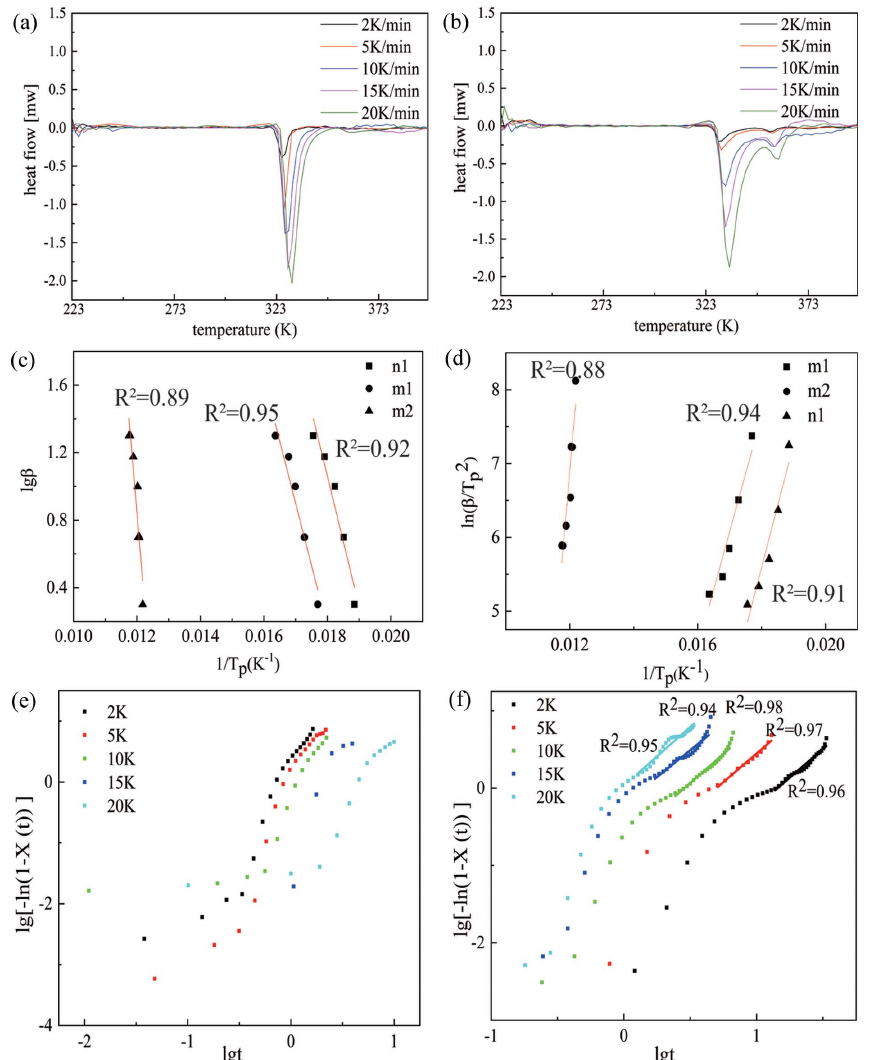
Figure 6 DSC thermograms of (cid:3) powder crystals after ( a ) 0 min of milling and ( b ) 90 min of milling at different heating rates. Estimation of the apparent activation energy by ( c ) the Ozawa model and ( d ) the Kissinger model. n1: the first phase transition of non-milled (cid:3) powders; m1 and m2: the first and second phase transitions of (cid:3) powder crystals after 90 min of milling. The (cid:3) ! (cid:2) phase transition process described by the Jeziorny model for ( e ) the non-milled polycrystalline powders and ( f ) polycrystalline powders after 90 min of milling.